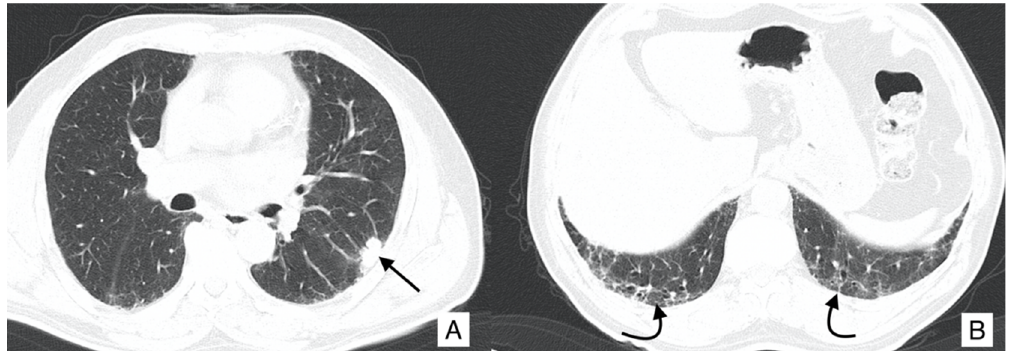
Figure 3. Axial HRCT images of a patient with IPF and lung cancer (LC). In ( A ), a lobulated lesion is depicted (black arrow), located at the periphery of the left lung. In ( B ), reticulations and bronchiectasis are clearly shown (black curved arrows), resembling a usual interstitial pneumonitis (UIP) probable pattern.